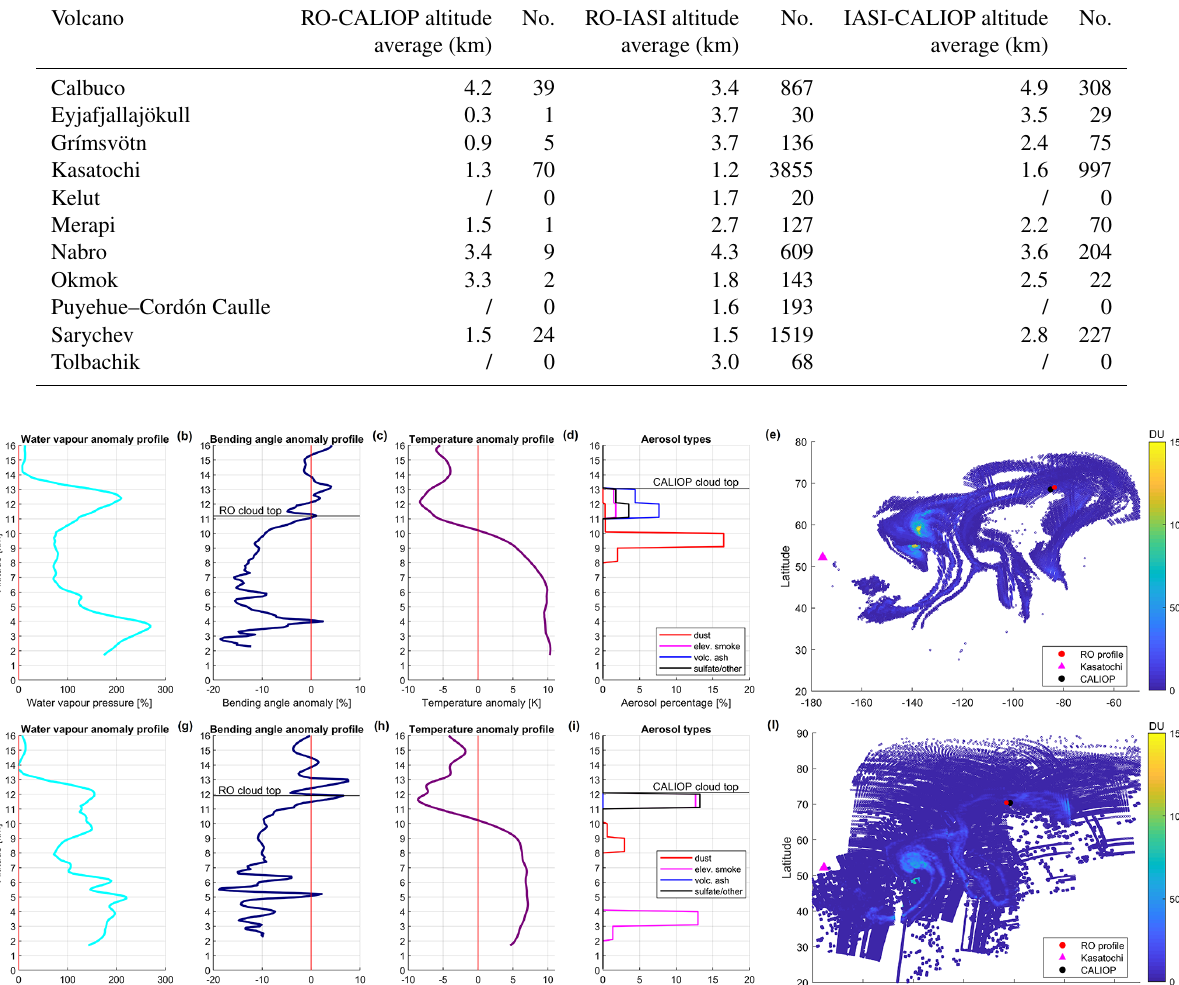
Table 5. The average difference between cloud-top height estimated with pairs of sensors for each volcano. For each pair we report the average difference (or simply the difference when there is only one collocation) of all the collocations and the number of collocations. When there are no collocations the value reported is “/”.